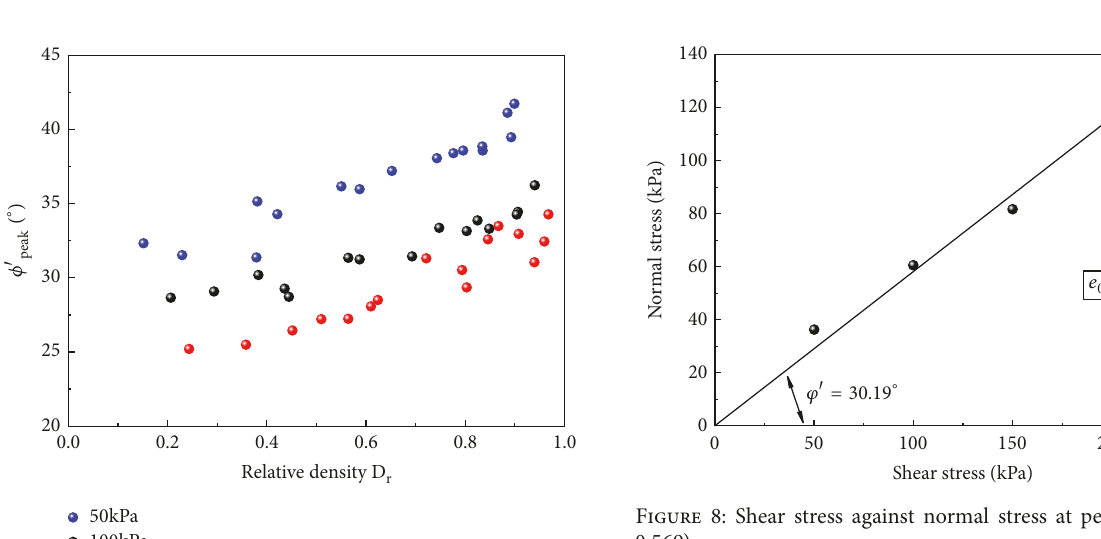
Figure 6: Experimental results of stress-strain response (150 kPa). (a) Shear stress ratio-horizontal displacement curve. (b) Vertical displacement-horizontal displacement.